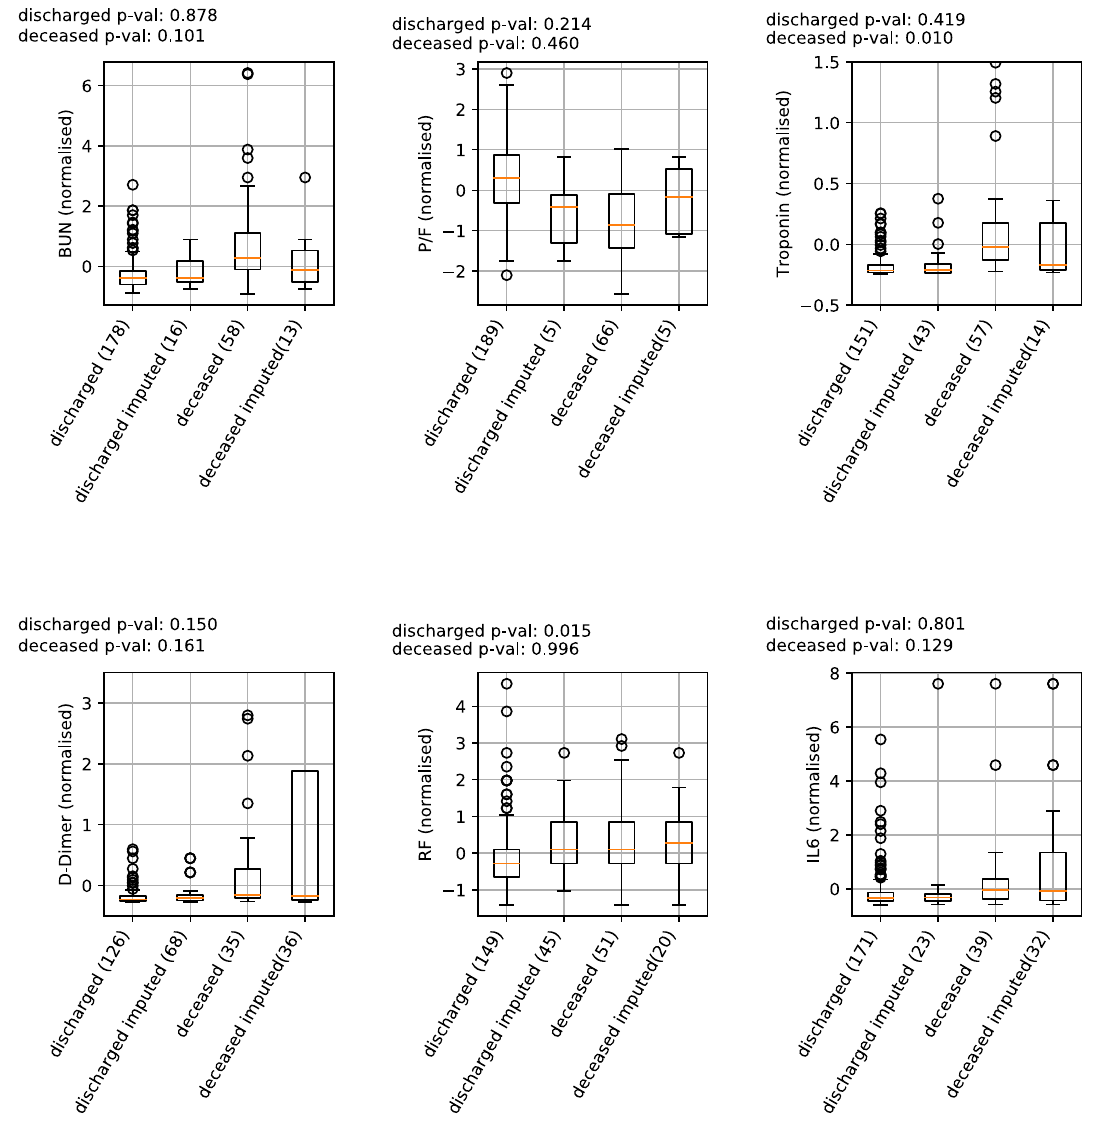
Figure 3. Distribution of a selection of measured and imputed clinical variables for discharged and deceased patients. The plots compare the values measured at hospitalisation with those imputed during our analysis. The p values correspond to two-sample Kolmogorov–Smirnov tests, comparing discharged versus discharged imputed and deceased versus deceased imputed . The labels on the x-axis show in parentheses the number of patients in each